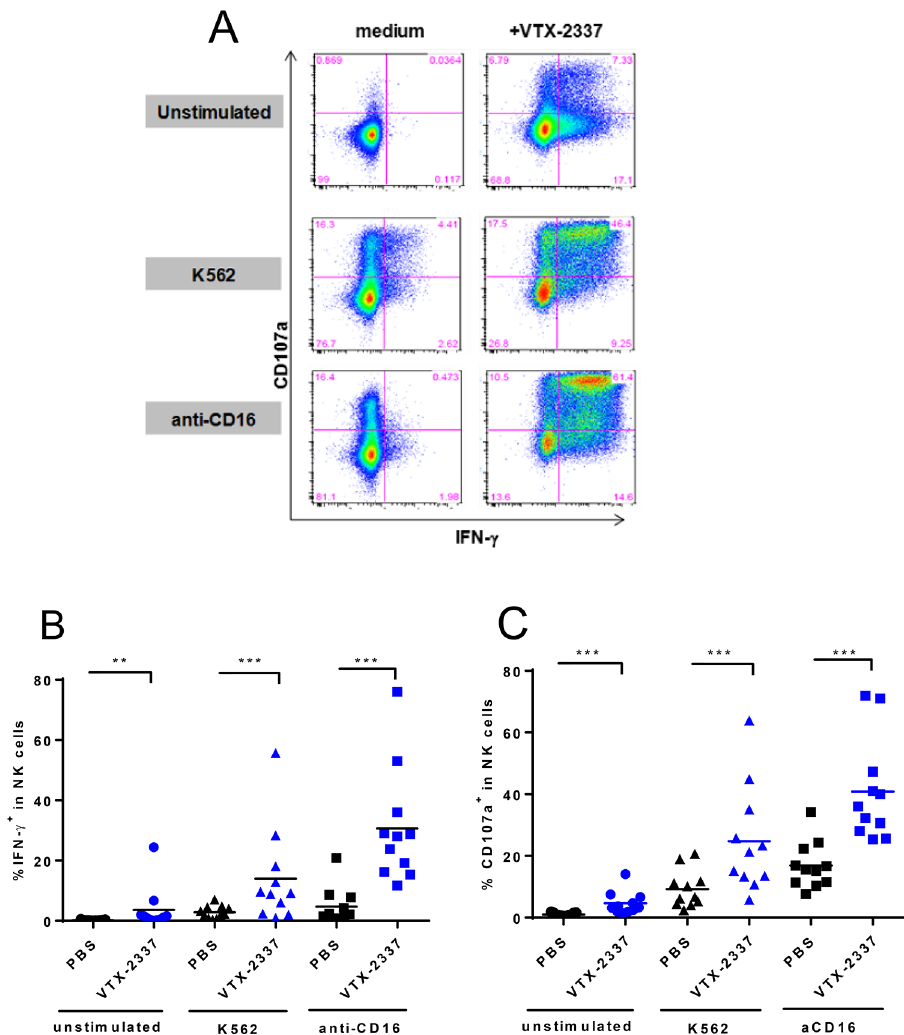
Fig 5. VTX-2337 enhances NK activation in response to stimulation by K562 cells and anti-CD16 in vitro . (A) FACS plots showing IFN γ and CD107a expression by NK cells following overnight cultured in medium or VTX-2337 (0.5 μ M), and then left unstimulated, stimulated with either K562 cells, or plate-bound anti-CD16 mAb. (B-C) Summary graphs of FACS analyses of NK cell activation in PBMC from 11 donors. Each data point represents an individual donor. The horizontal bar represents group average. Each donor was analyzed in an independent experiment. * , p < 0.05, ** , p < 0.01, *** , p < 0.001 by Wilcoxon signed-rank